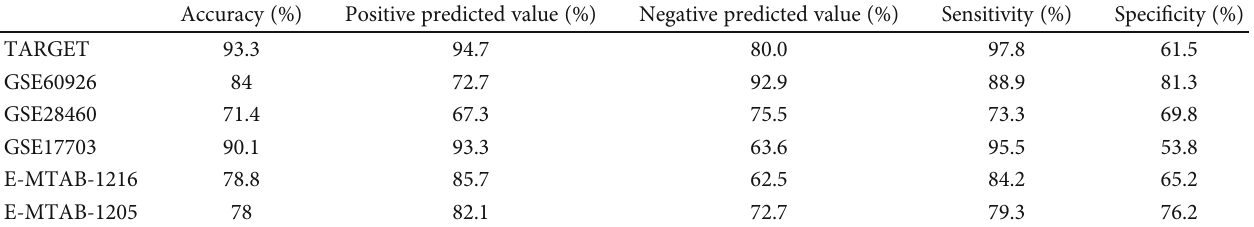
Table 4: Validation of the prognostic classi fi er models for recurrence prediction.